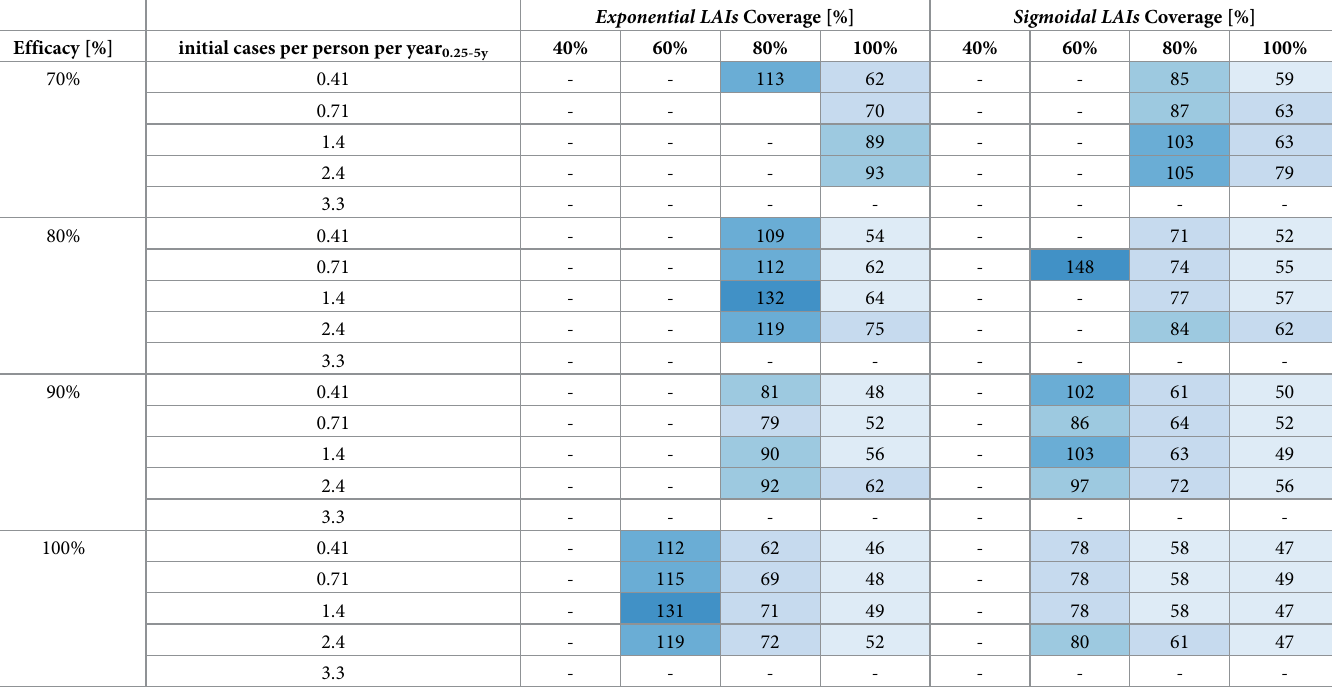
Table 2. Illustration of the trade-offs between LAI protective efficacy half-life, initial protective efficacy and coverage in implementation stages . Exponential LAIs Coverage [%] Sigmoidal LAIs Coverage [%] Efficacy [%] initial cases per person per year